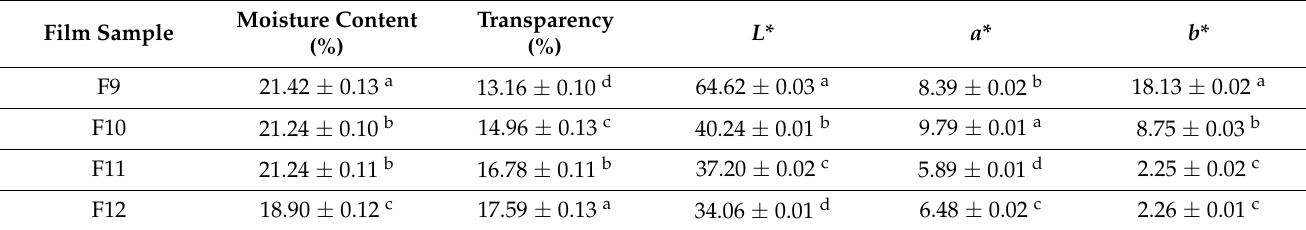
Table 2. Moisture content, transparency, and color value of films prepared using FPC at different